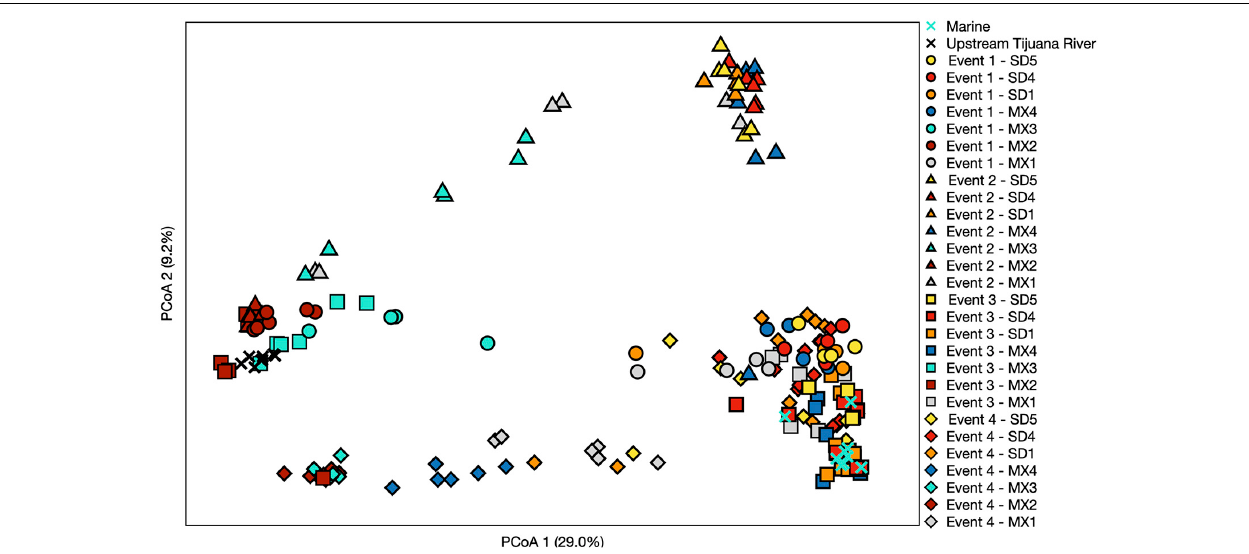
FIGURE 5 | Principal coordinate analysis performed using a Bray–Curtis dissimilarity matrix. Each symbol represents a different sampling event, while each color represents a different site. Three sites north of the United States/Mexico border were chosen to include that represent trends observed. Numbers in parentheses denote % of variation explained by each axis.